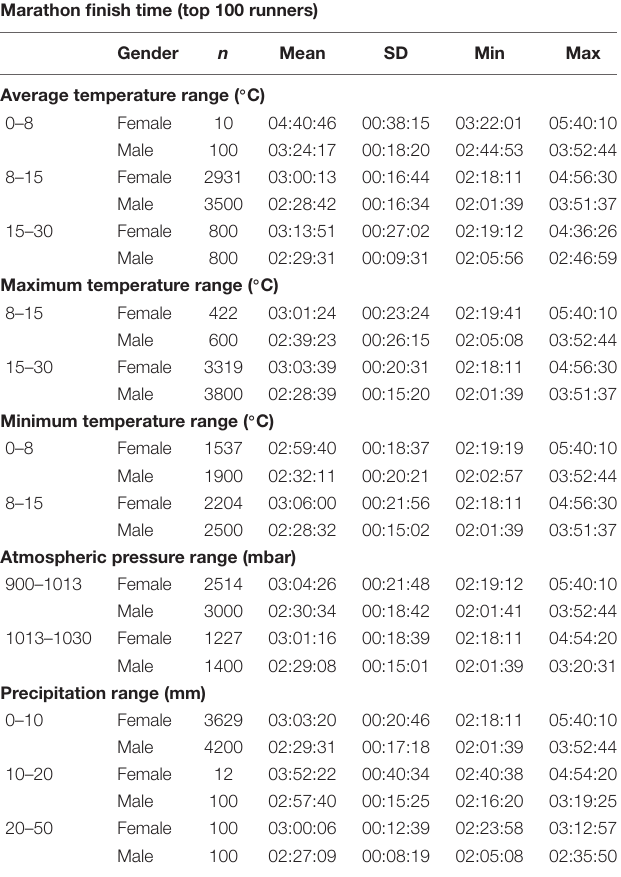
and sunshine duration, (2) elite runners (i.e., top 3 and top 10) seemed to run faster and improved their race times when the temperature increased, where the top 10 women appeared to benefit more than the top 10 men, and (3) male top 100 runners seemed to benefit more than female top 100 runners from increasing